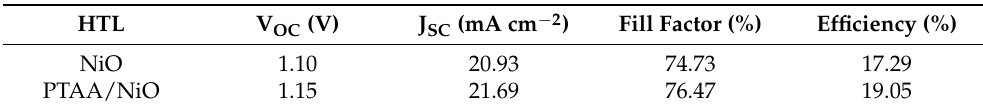
Figure 4 summarizes the changes in all output parameters: PCE, fill factor (FF), open circuit voltage (V OC ), and short circuit current (J SC ) using corresponding representative J–V curves for devices manufactured with different HTLs. The PSCs that had the